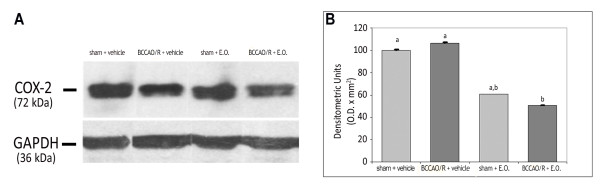
(A)Western blot analysis of COX-2 in the frontal cortex of rats submitted to sham operation and to BCCAO/R, pre-treated either with the vehicle alone or with the E.O. (B) Relative levels of COX-2 expression with densitometric analysis of the gray levels expressed as a percentage of the optical density (O.D.) ratio of the COX-2-positive bands to the GAPDH-positive ones. Error bars depict standard deviation. Different letters denote significant differences (p < 0.05).